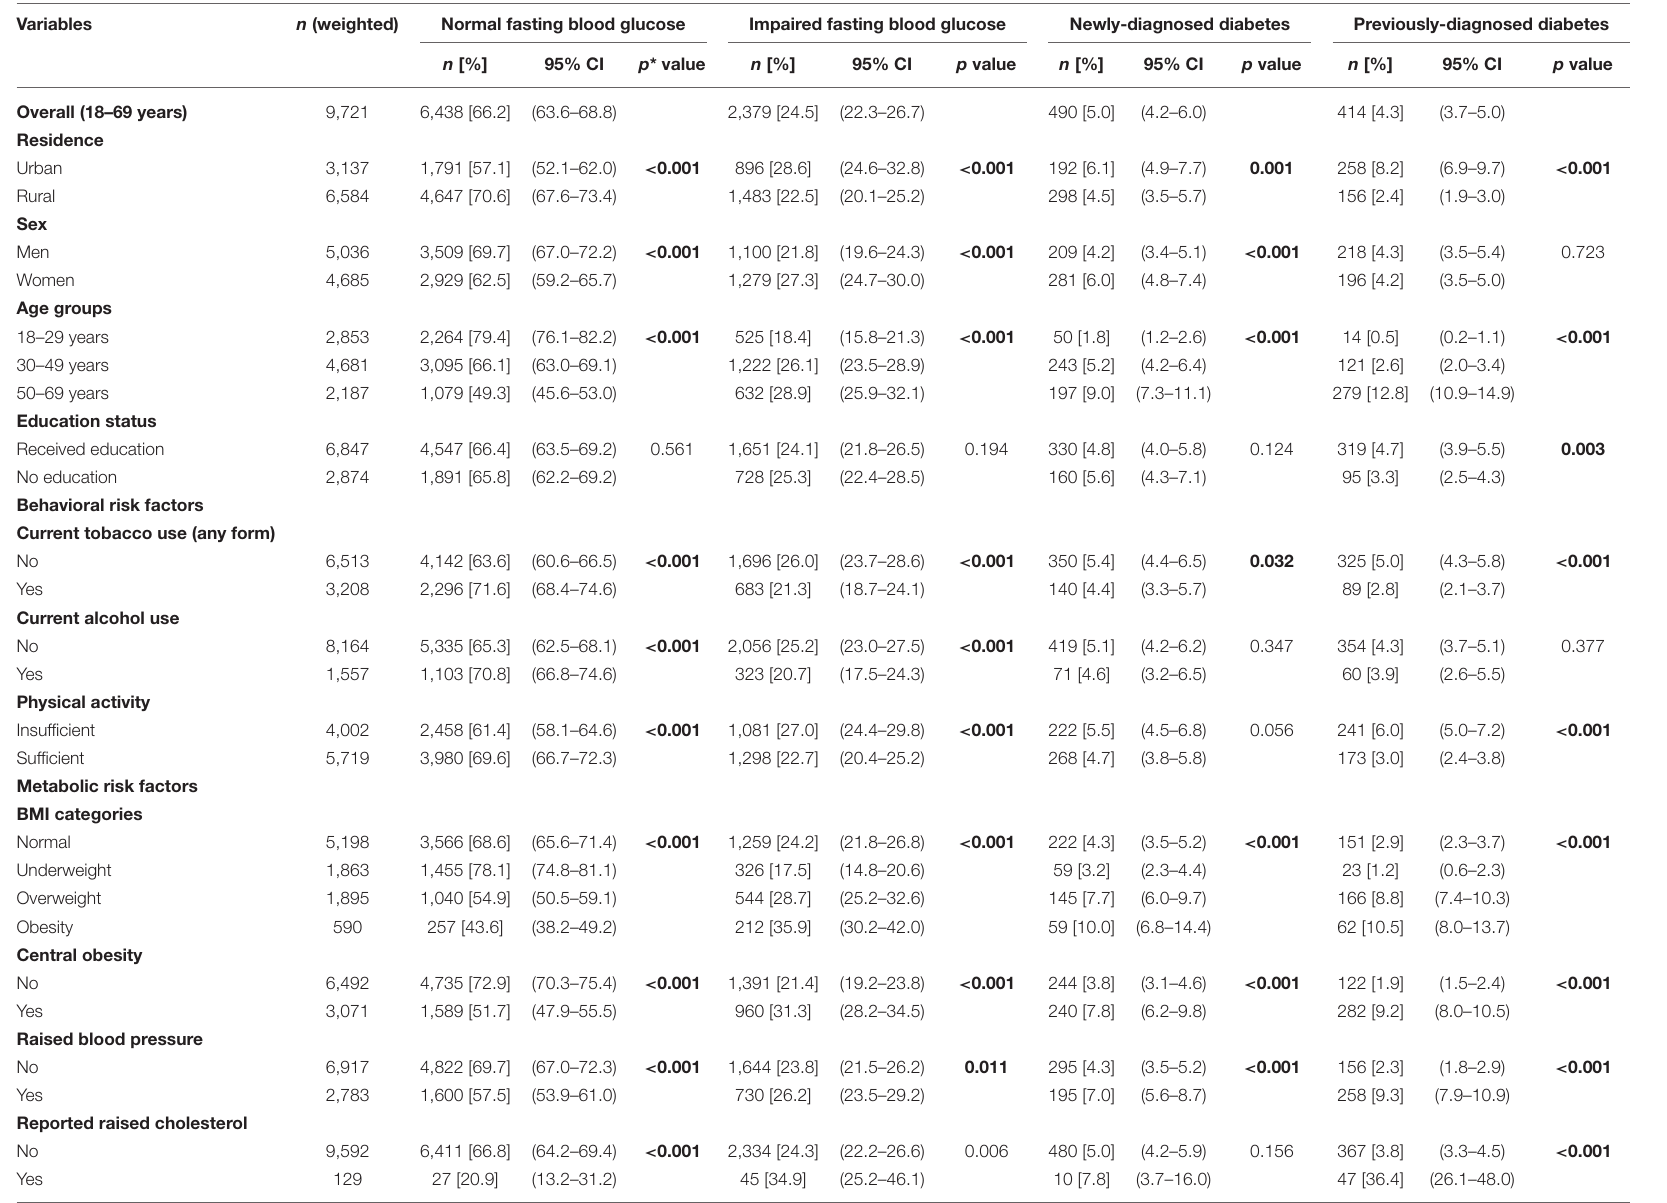
TABLE 1 | Distribution (Percentage) of socio-demographic and risk factor profile of Indian adult population (18–69 years) by fasting blood glucose categories. Variables n (weighted) Normal fasting blood glucose Impaired fasting blood glucose Newly-diagnosed